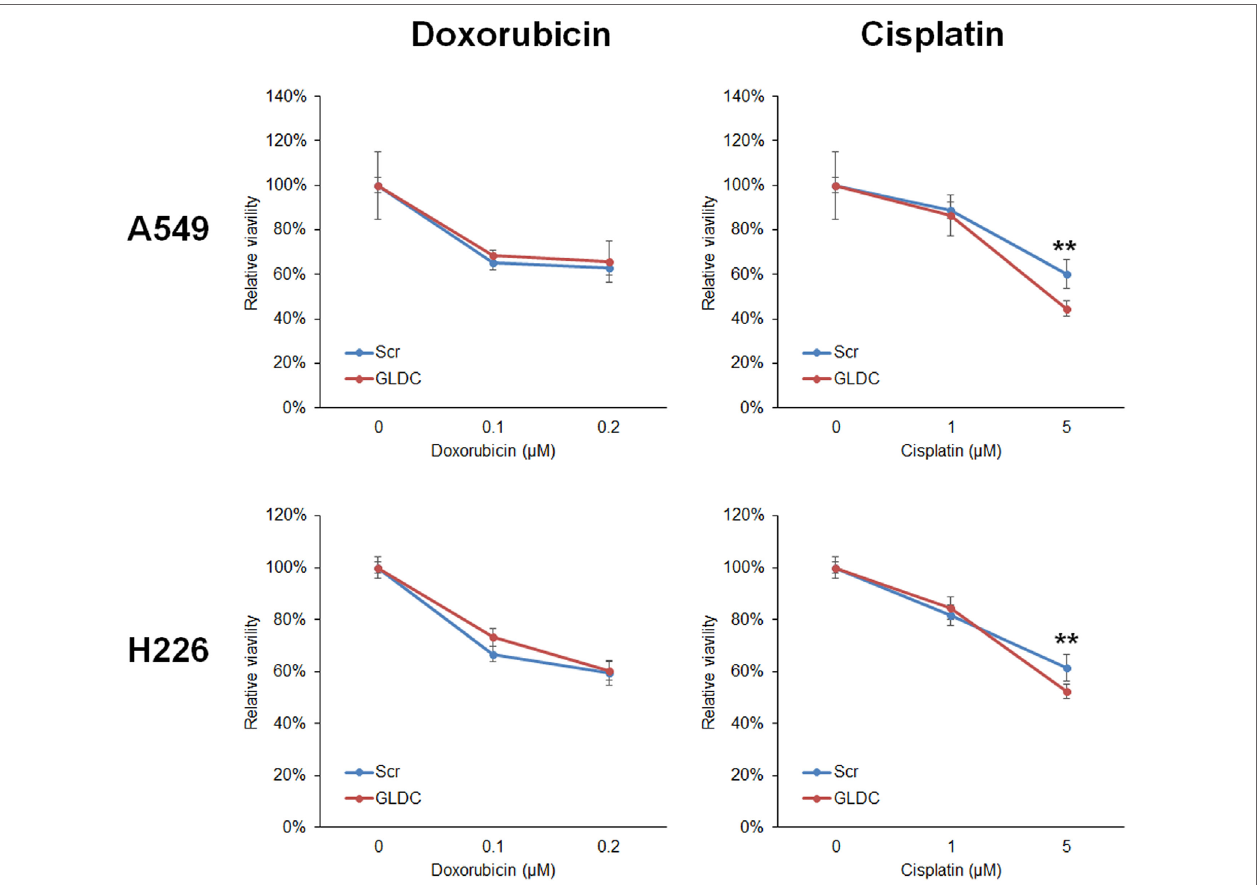
FigUre 6 | Glycine decarboxylase (GLDC)-steric hindrance antisense oligonucleotide (shAON) treatment produces enhanced cytotoxicity with cisplatin. MTT assay to show the combined effect of antitumor drug and GLDC-shAON to the viability of A549 and H226 cells. 2,000 cells were seeded into 96-well microplate for overnight incubation followed by doxorubicin/cisplatin and shAON treatments for 3 days. The absorbance was normalized to the vehicle control. The data represent mean ± SEM of three independent experiments (** p <